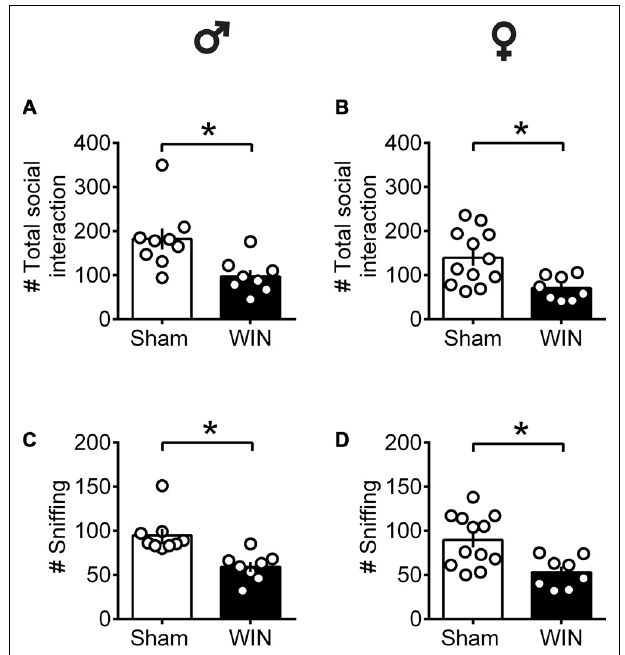
FIGURE 2 | Social interactions are diminished in adult rats of both sex 24 h after a single in vivo cannabinoid exposure. Adult male (A) and female (B) rats had fewer social contacts with their congeners 24 h following a single exposure to WIN55,212-2 (2 mg/kg, s.c.). Similarly, sniffing was reduced in both adult male (C) and female (D) rats 24 h following a single exposure WIN, compared to control animals. Data represent mean ± SEM. Scatter dot plot represents a pair of animals. ∗ p < 0.05, Mann-Whitney U